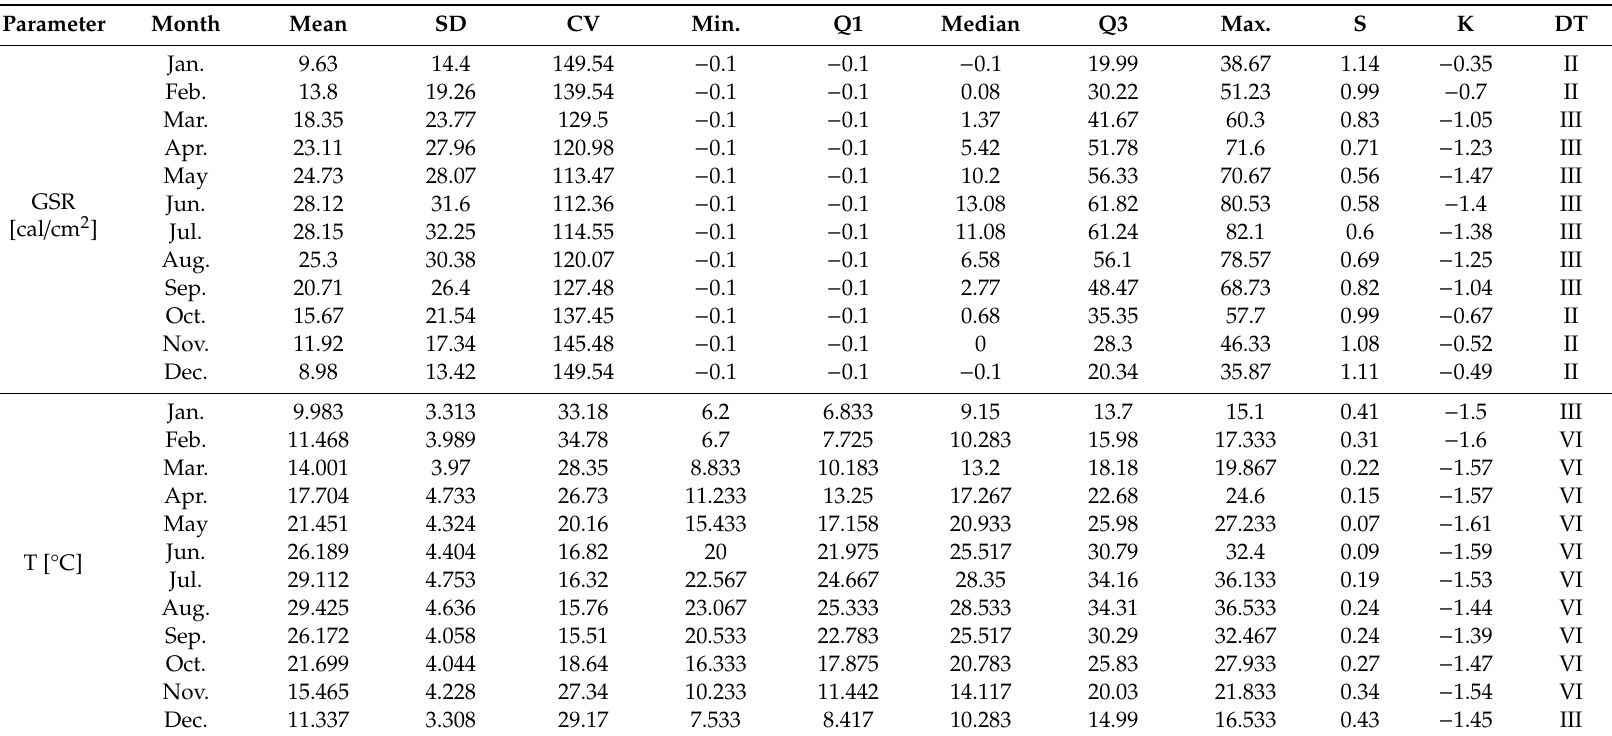
Table 6. Statistical estimators of the mean hourly meteorological parameters for the period